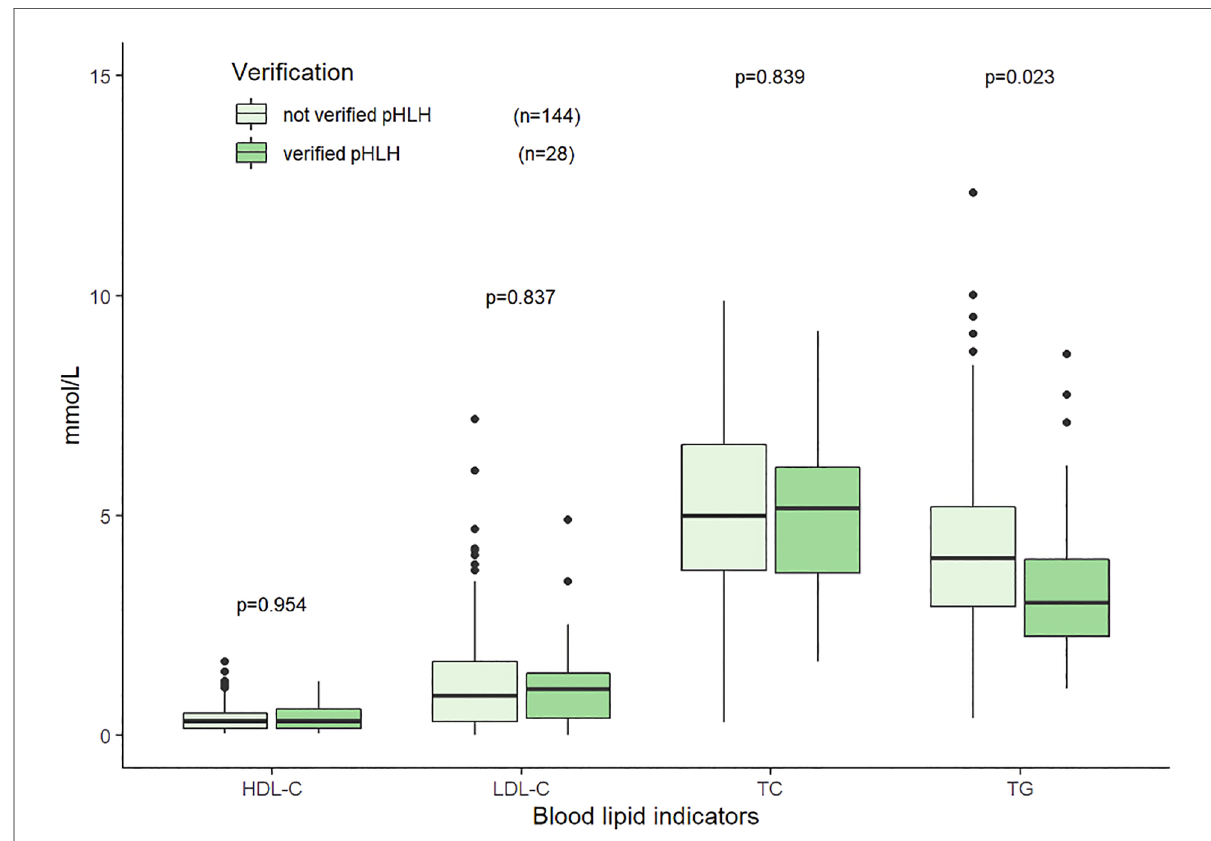
FIGURE 4 Distributions of blood lipid indicators in the patients with genetically veri fi ed pHLH and without veri fi ed pHLH. Note: 172 patients tested for both HLH related gene testing and lipid